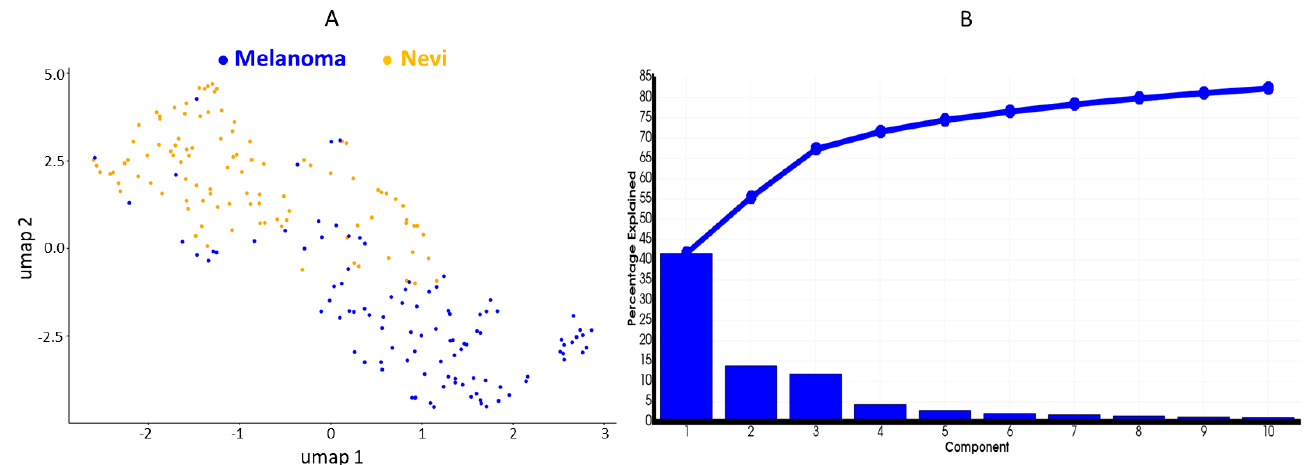
Figure 1. Dimensionality reduction of the imaging mass spectrometry (IMS) spectral data analyzed by SCiLS Lab and R statistical software. ( A ) Uniform Manifold Approximation and Projection (UMAP) two-dimensional (2D) plot of melanoma (blue spots) and melanocytic nevi (yellow spots). The results show a differential distribution of the two spot regions in the dataset. ( B ) Variance plot of the principal component analysis (PCA) showing the first three components containing approximately 70% of the variance percentage of the data.